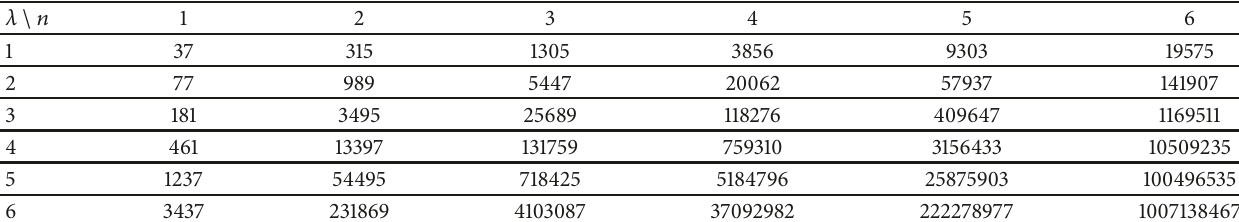
Table 4: Modified Wiener index of 𝑅𝑇𝑂𝑋